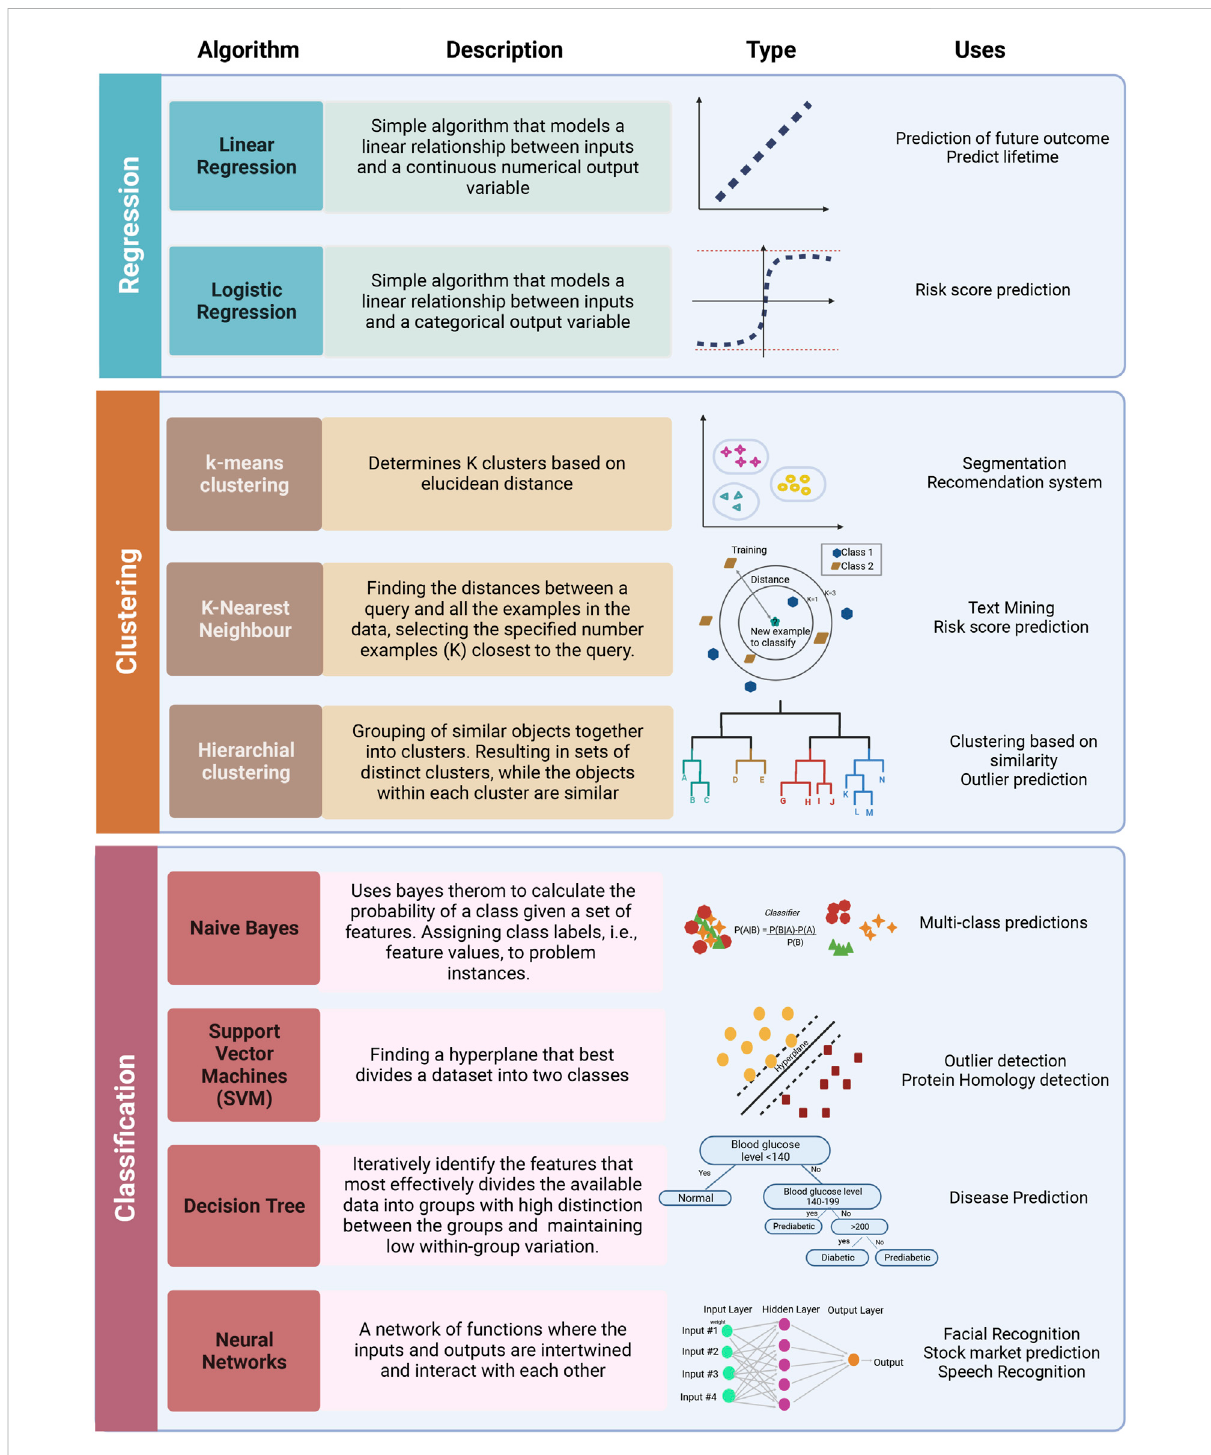
FIGURE 4 Representation of most commonly used ML algorithms with functional categorization accompanied by graphical representations of each algorithm and some potential applications. The most frequently used algorithms can be grouped into regression (linear and logistic), clustering (k-means, k-NN, hierarchical clustering, NN), and classi fi cation (Naive Bayes, SVM, Decision trees). Created with